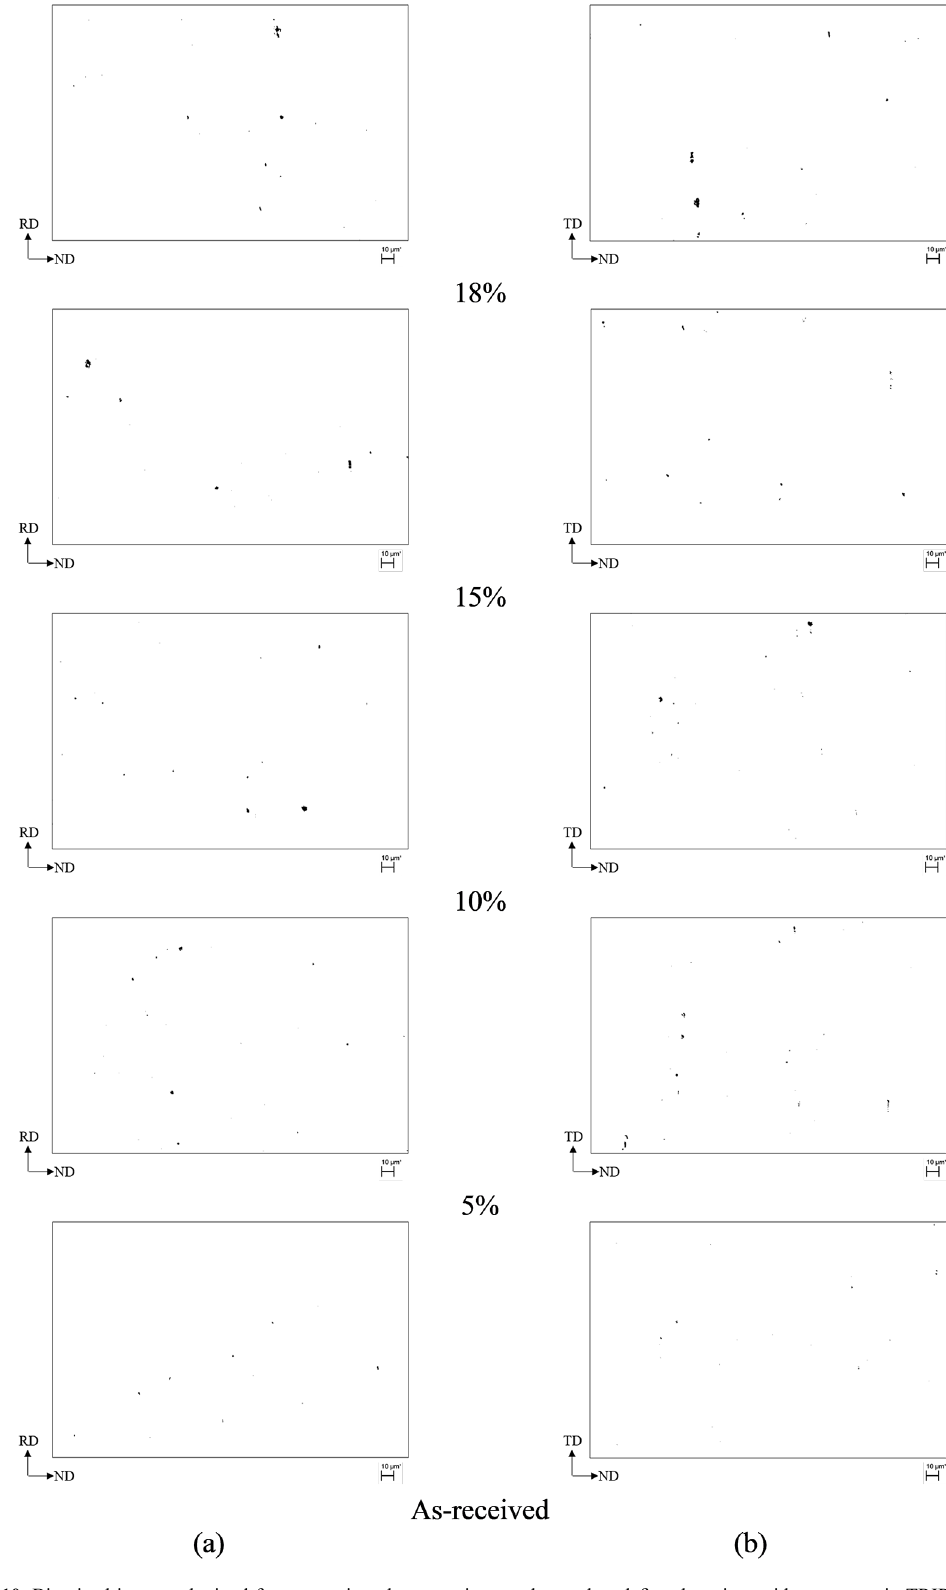
Figure 10. Binarized images obtained from scanning electron micrographs used to define the microvoids measures in TRIP780 steel samples from as-received and pre-strained conditions: (a) parallel cross-section (ND – Normal Direction and RD – Rolling Direction) and (b) transverse cross-section (ND – Normal Direction and TD – Transverse